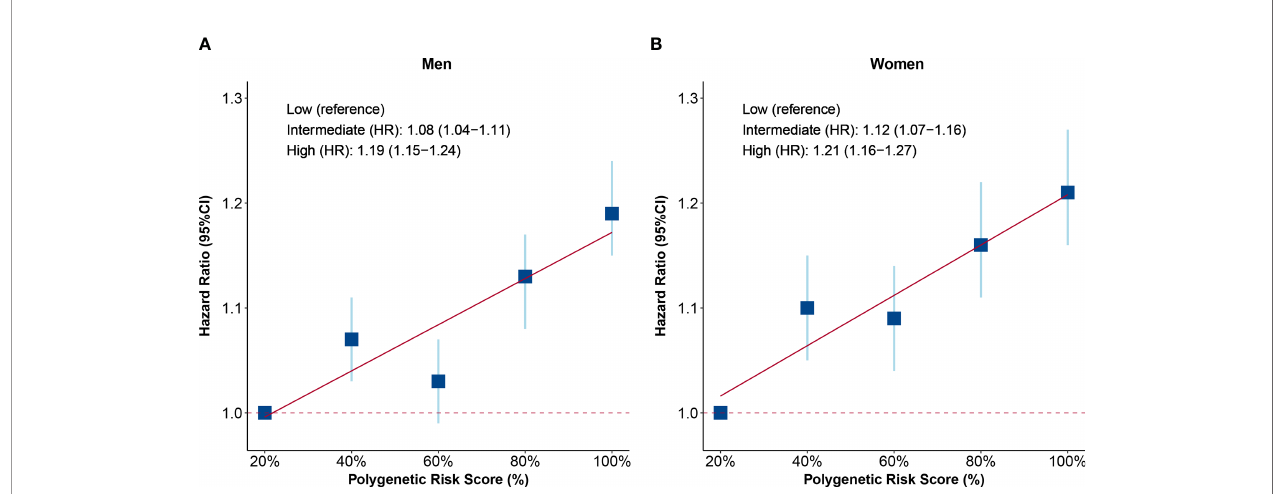
FIGURE 2 | Associations of polygenetic risk score (PRS) with risk of health span termination. (A) PRS in men and (B) PRS in women. Participants were divided into fi ve groups according to the quintiles of PRS, and the HRs of each quintile were compared with those in the bottom quintiles. The level of PRS was further divided into three groups: low (quintile 1), intermediate (quintiles 2 – 4), and high (quintile 5). The blue squares are point estimation of HRs and error bars are 95% CIs. Fully adjusted model: age, menopause status (for women), college or university degree, deprivation index, body mass index, smoking status, alcohol drinking, IPAQ group, healthy diet, family history of CCVD or cancer, use of aspirin/ibuprofen, use of hormone replacement therapy (for women), the top 10 principal components of ancestry, and genotyping chip. HR, hazard ratio; CI, con fi dential